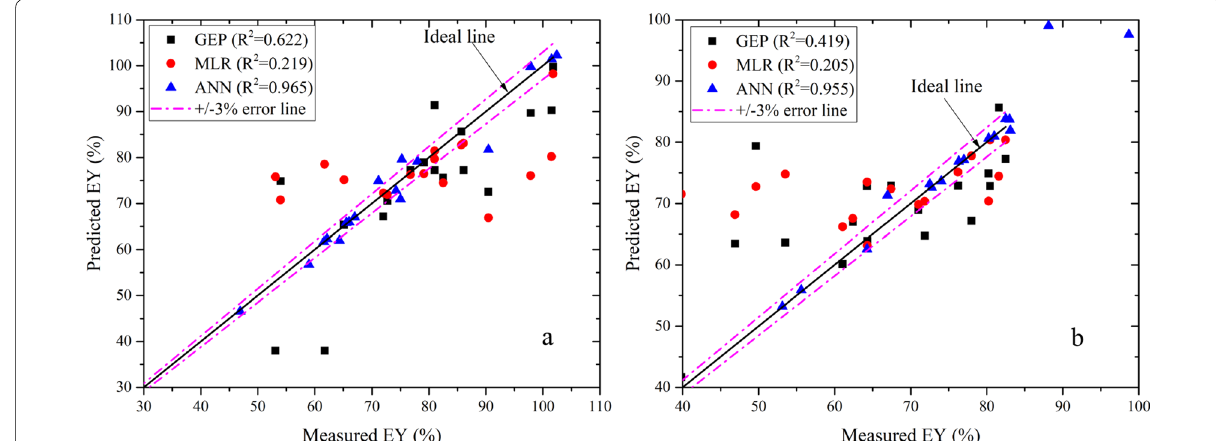
Fig. 9 Model comparison for the EY using a testing datasets, b validation datasets